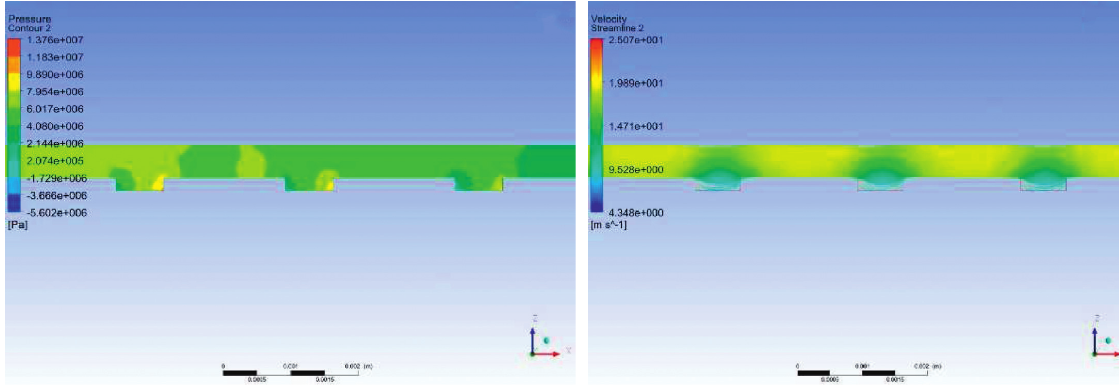
Figure 6: 700 micron diameter and 200 micron depth texture fluid pressure diagram and streamline diagram.